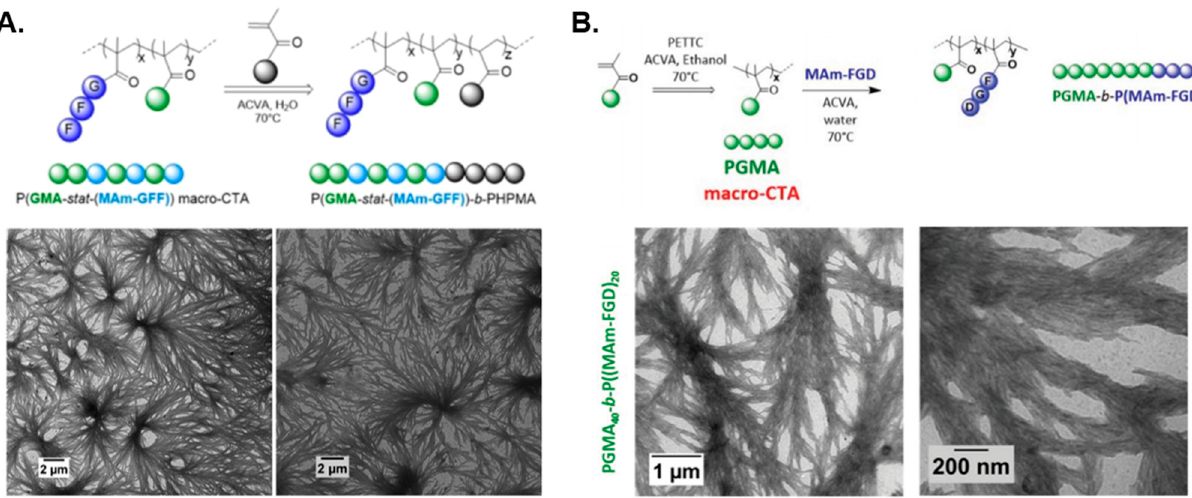
Figure 4. ( A ) Synthesis of P(GMA- stat -(MAm-GFF))- b -PHPMA block copolymer nanostructures via aqueous RAFT-mediated PISA (top), and representative TEM images of developed dendritic fibers (bottom). Adapted with permission from reference [77]. Copyright 2020 American Chemical Society. ( B ) Synthesis of PGMA- b -P(MAm-FGD) block copolymer nanostructures via aqueous RAFT-mediated PISA (top), and representative TEM images of prepared dendritic fibers (bottom). Adapted with permission from reference [80]. Copyright 2021 Royal Society of Chemistry.